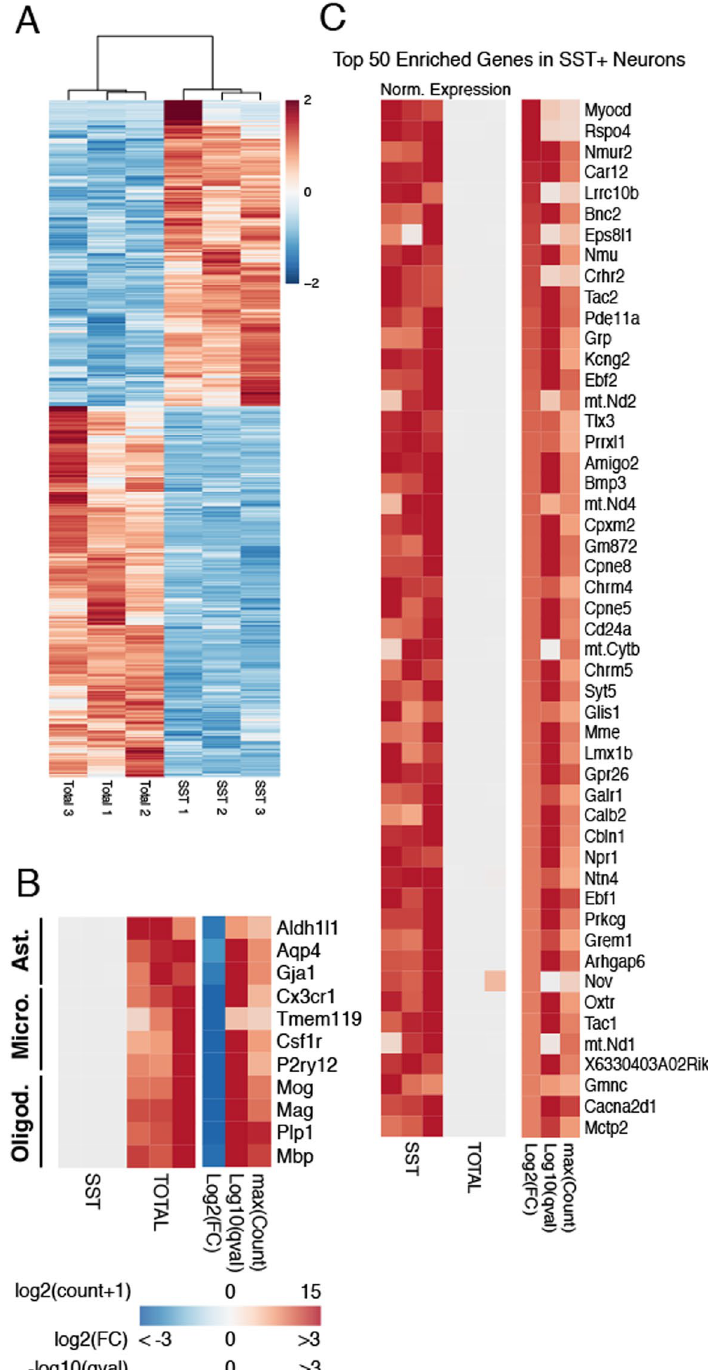
Figure 2. Differential Gene Expression in SST Neurons. ( A ) Hierarchical clustering of SST neurons and total dorsal horn nuclei reveals widely divergent gene expression patterns. Color scale indicates Z-score of normalized expression values. ( B ) Non-neuronal markers are depleted from SST neurons. Ast. = Astrocytes, Micro. = Microglia, Oligod. = Oligodendrocytes. In the left heatmap, the expression level in each sample is normalized by the maximum expression level in the row (Norm. Expression). The right heatmap shows the log2-Fold Change (log2FC), − log10 of the q-value (adjusted p-value) and the log2 of the maximum value of counts for each gene plus a psuedocount of 1 (maxCount). Note: Positive values for log2FC indicate enrichment in SST compared to Total, while negative values indicate enrichment in Total compared to SST. ( C ) Top 50 Differentially Expressed Genes in SST neurons. Genes are ordered by log2FC value from highest to lowest. Criteria for inclusion of genes: log2FC > 1, q-value < 0.01 and CV < 65% and a minimum of 20 counts for all